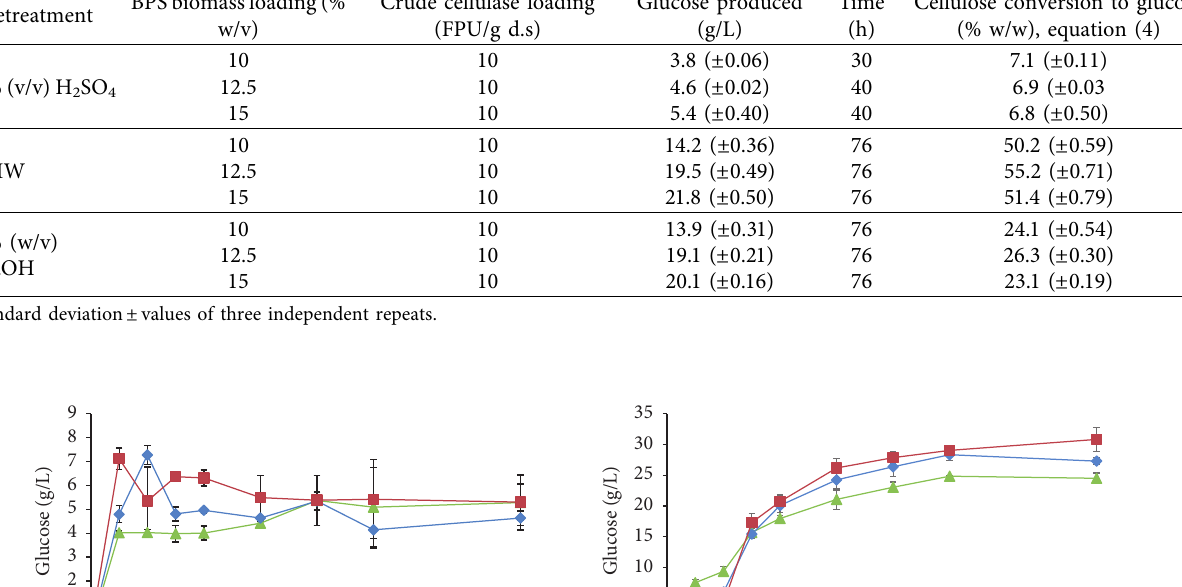
Table 3: Summary of the enzymatic hydrolysis of pretreated banana pseudostems at varying solid loadings by crude enzymes produced by Trichoderma harzianum LMLBP07 13-5. BPS biomass loading (% Crude cellulase loading Pretreatment w/v) (FPU/g d.s)